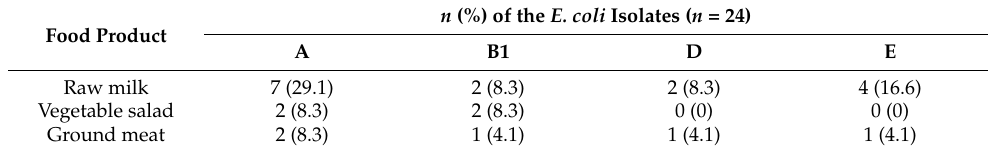
Figure 2. Phylogenetic group distribution of E. coli strains isolated from food samples. Table 3. Distribution of phylogroups among the E. coli isolates obtained from different food products.